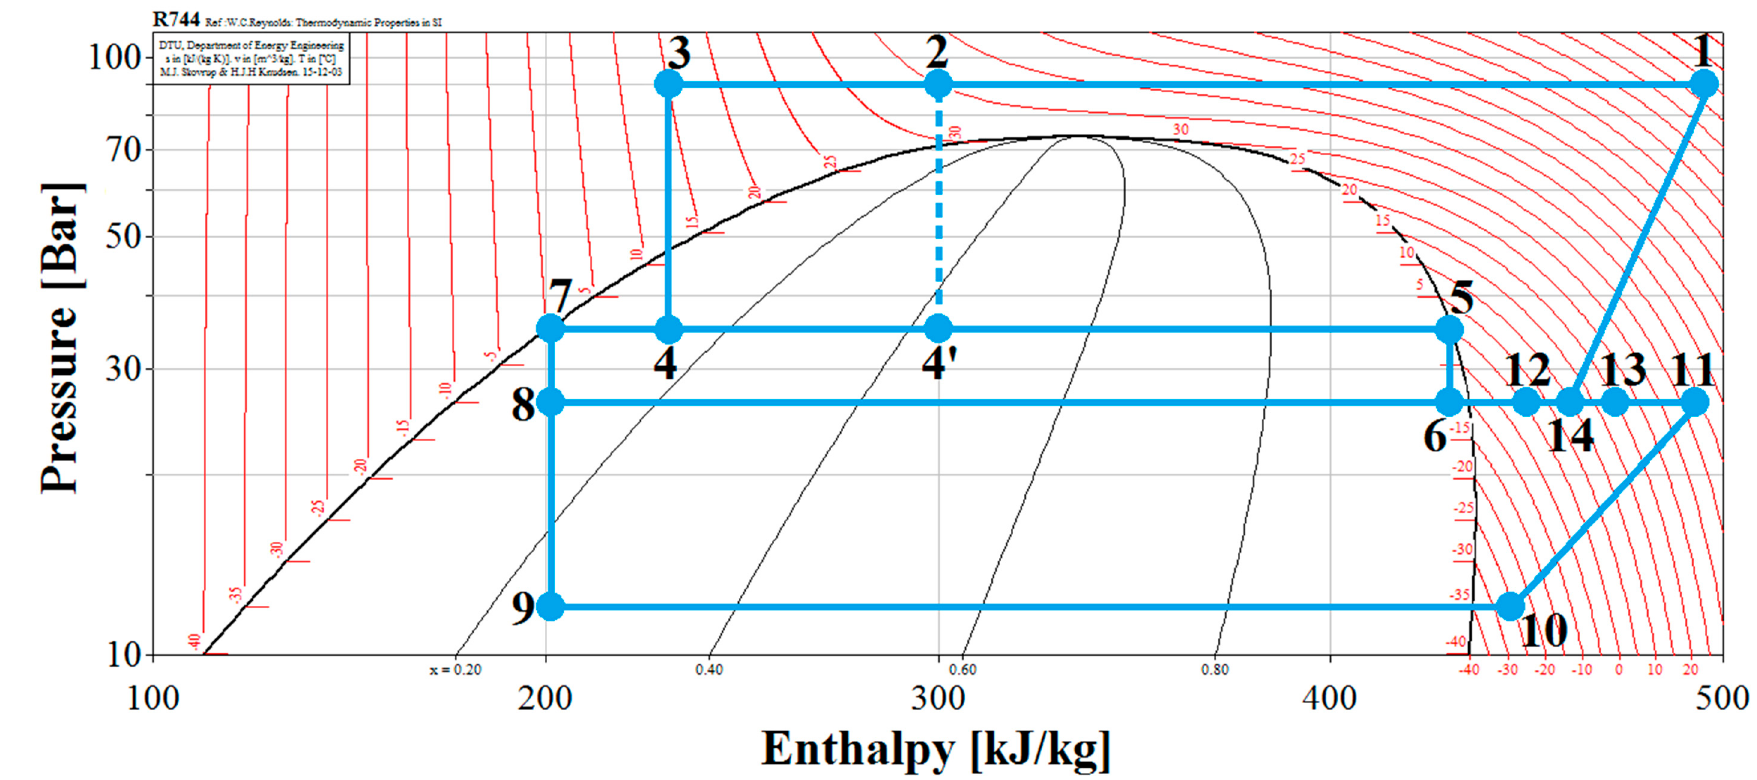
Figure 2. Log(p)-h diagram of R744 booster refrigeration systems with and without dedicated mechanical subcooling [8].